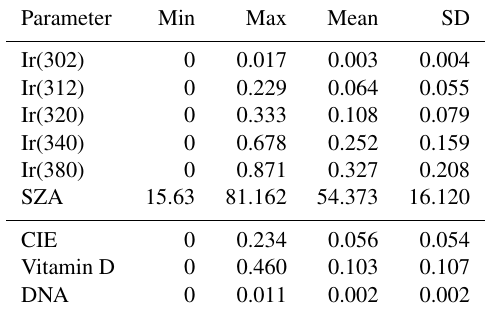
Table 1. Range of validity of the trained optimal NN as determined by its input parameters (upper list) and output parameters (lower